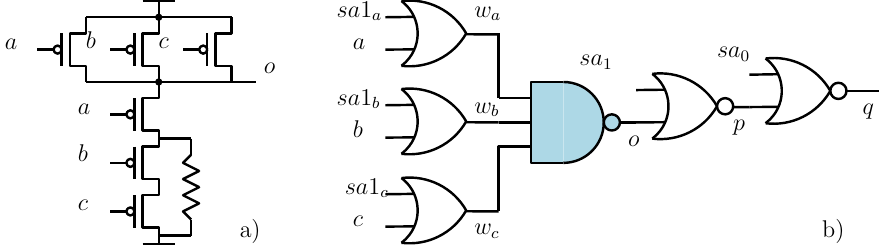
Figure 2. ( a ) Three-input NAND cell affected by an internal bridging fault. ( b ) Structural injection of input and output stuck-at faults for the same